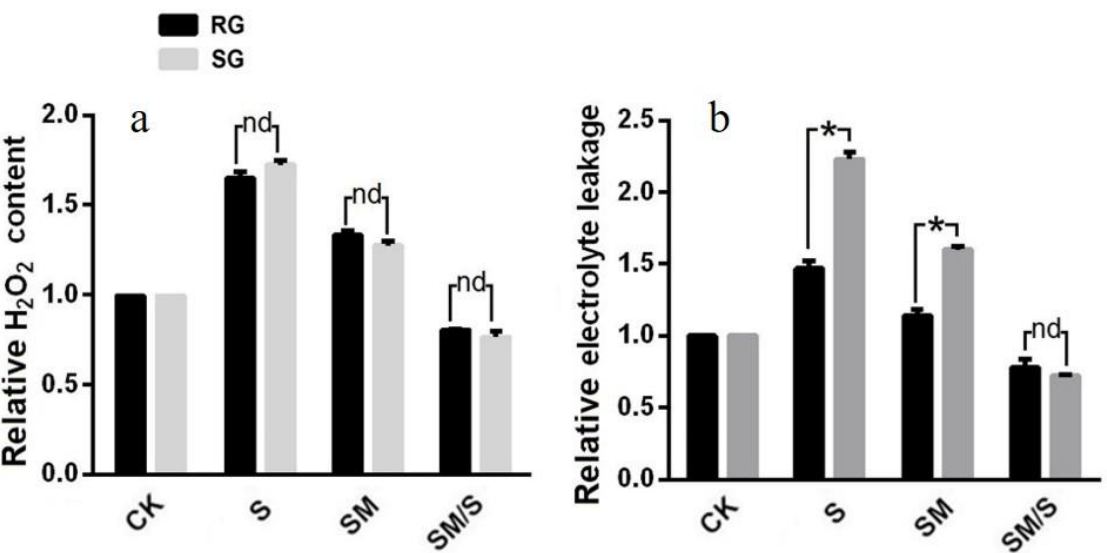
Figure 2. Relative H 2 O 2 content ( a ) and relative electrolyte leakage ( b ) between salt-resistant and salt-sensitive tomato seedlings under salt stress. All the indices are normalized to CK. RG: salt-resistant genotype; SG: salt-sensitive genotype; CK: 1/2 Garden nutrient solution of Japan (GNSJ) + spraying distilled water; M: GNSJ + spraying 100 μM melatonin; S: GNSJ-NaCl (containing 200 mM NaCl) + spraying distilled water; SM: GNSJ- NaCl (containing 200 mM NaCl) + spraying 100 μM melatonin. The asterisk indicates the significant difference detected by Student’s t -test ( p < 0.05 marked with *). nd: no difference. Mean ± SE were given (n = 3, biological replications).